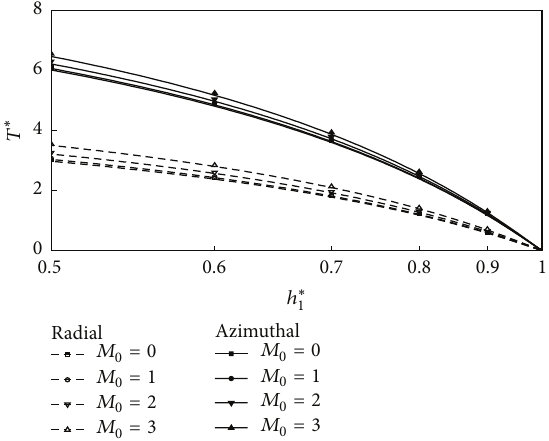
Figure 7: Variation of nondimensional load carrying capacity 𝑇 ∗ with ℎ ∗ 1 for different values of 𝑀 0 with 𝑙 ∗ = 0.3 and 𝐶 = 0.3 .